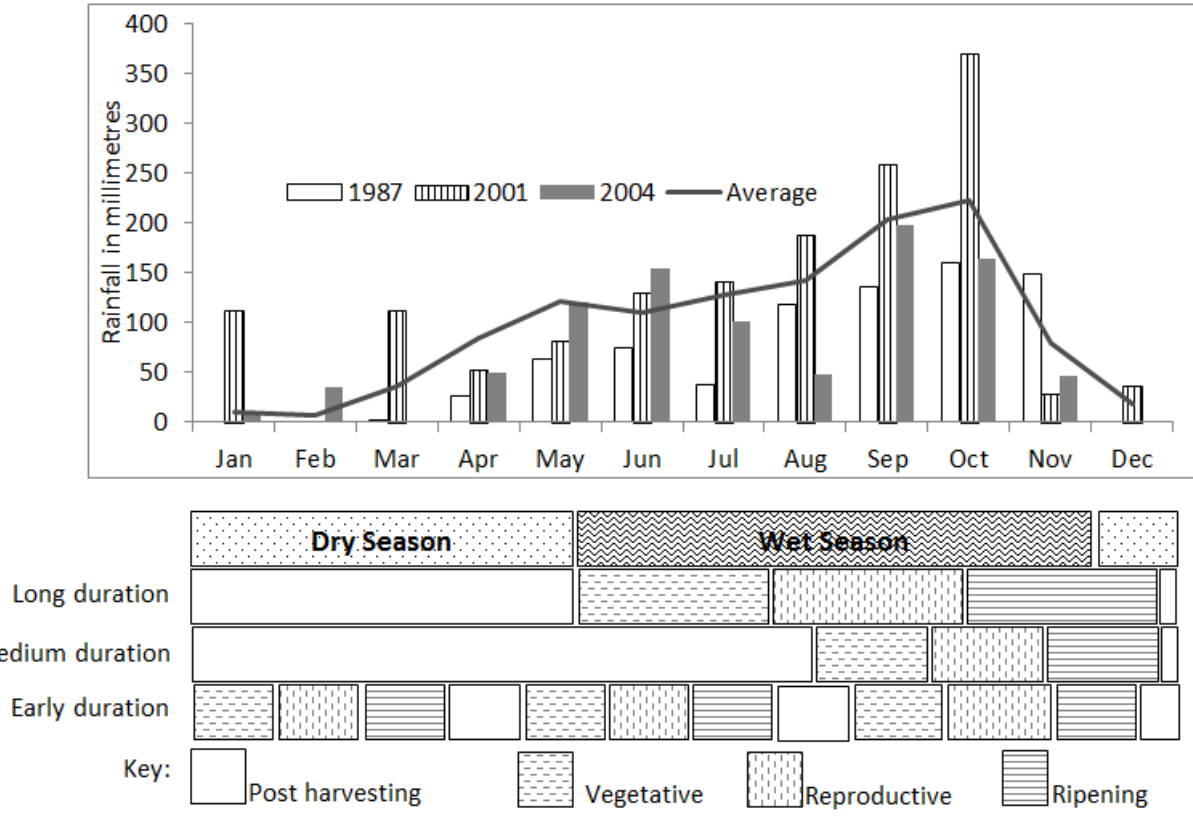
Figure 1. Kampong Speu climate station: mean monthly average rainfall (1983–2012) and monthly rainfall totals for three indicative years. Rice development phases for long-, medium- and early-season rice varieties are provided below the rainfall data. Sources: (rainfall: Department of Water Resources and Meteorology, rice development data: [fieldwork